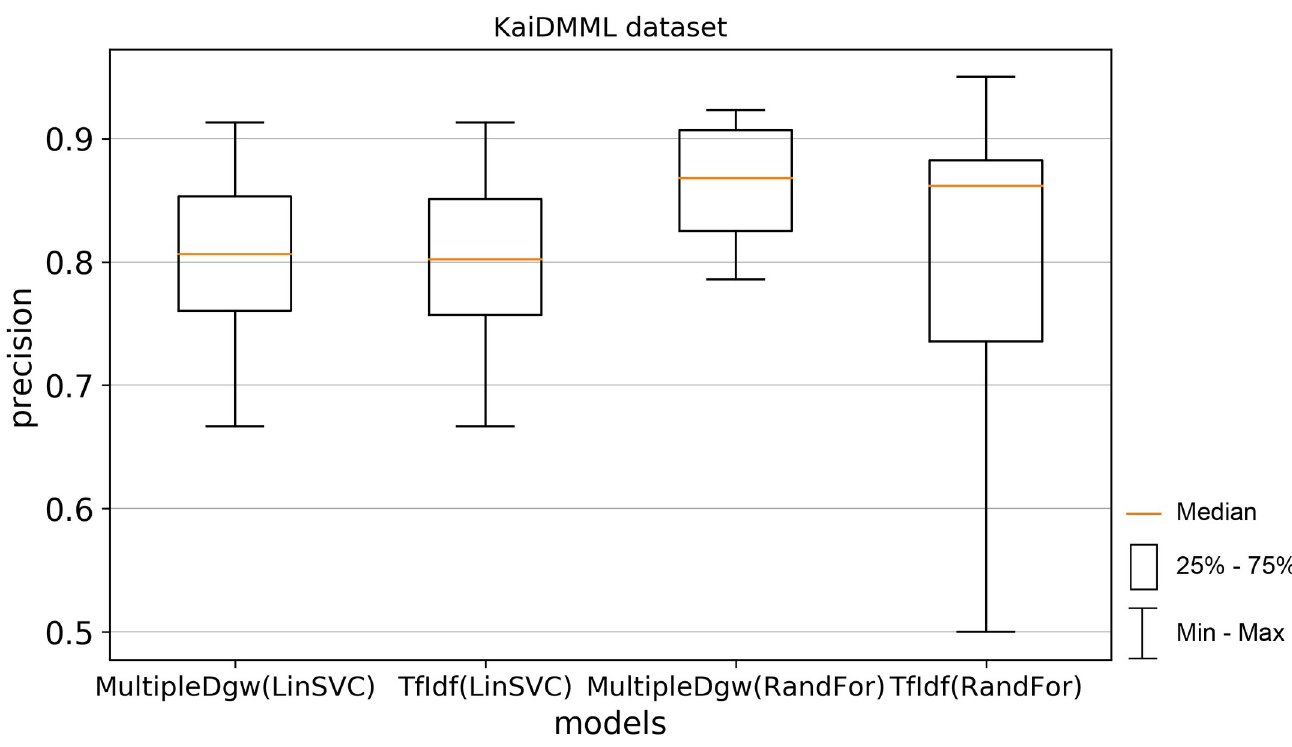
Fig 5. Boxplot for the model performance measurements—precision for dataset KaiDMML.